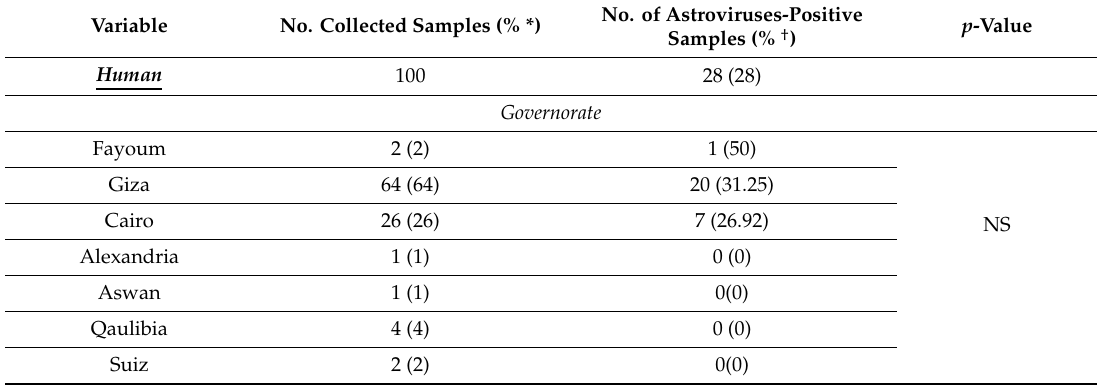
Table 1. Epizootiologic data of astroviruses in humans, bats, and wild birds in Egypt.